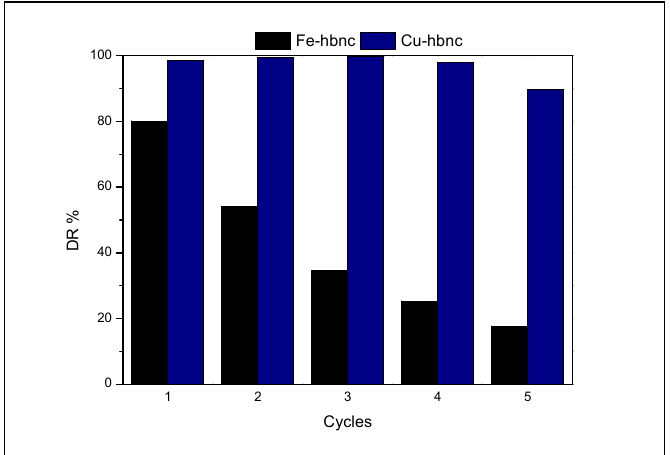
Figure 7. DR % during five reaction cycles on Fe-hbnc and Cu-hbnc (IC initial concentration 0.03 mM, molar ratio H 2 O 2 /IC = 32.6, 25°C, 2h, 150 rpm, 1 wt% catalyst).